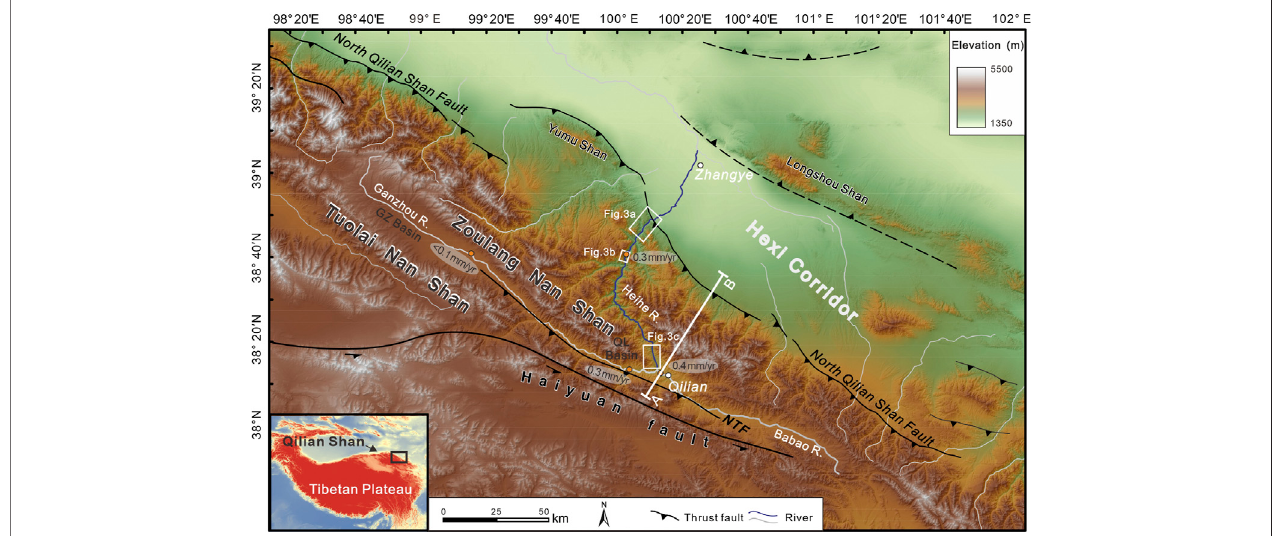
FIGURE1| TopographicmapofthenortheasternTibetanPlateau(derivedfrom90 mSRTMdata).Thebluelineindicatesthe fl uvialreachshownin Figure2B .The orange dots represent partial erosion rates estimated from cosmogenic 10 Be concentrations in river sediments (Palumbo et al., 2011; Hetzel, 2013; Hu et al., 2015a). NTF, North Tuolai Shan Fault; GZ Basin, Ganzhou River Basin; QL Basin, Qilian Basin.